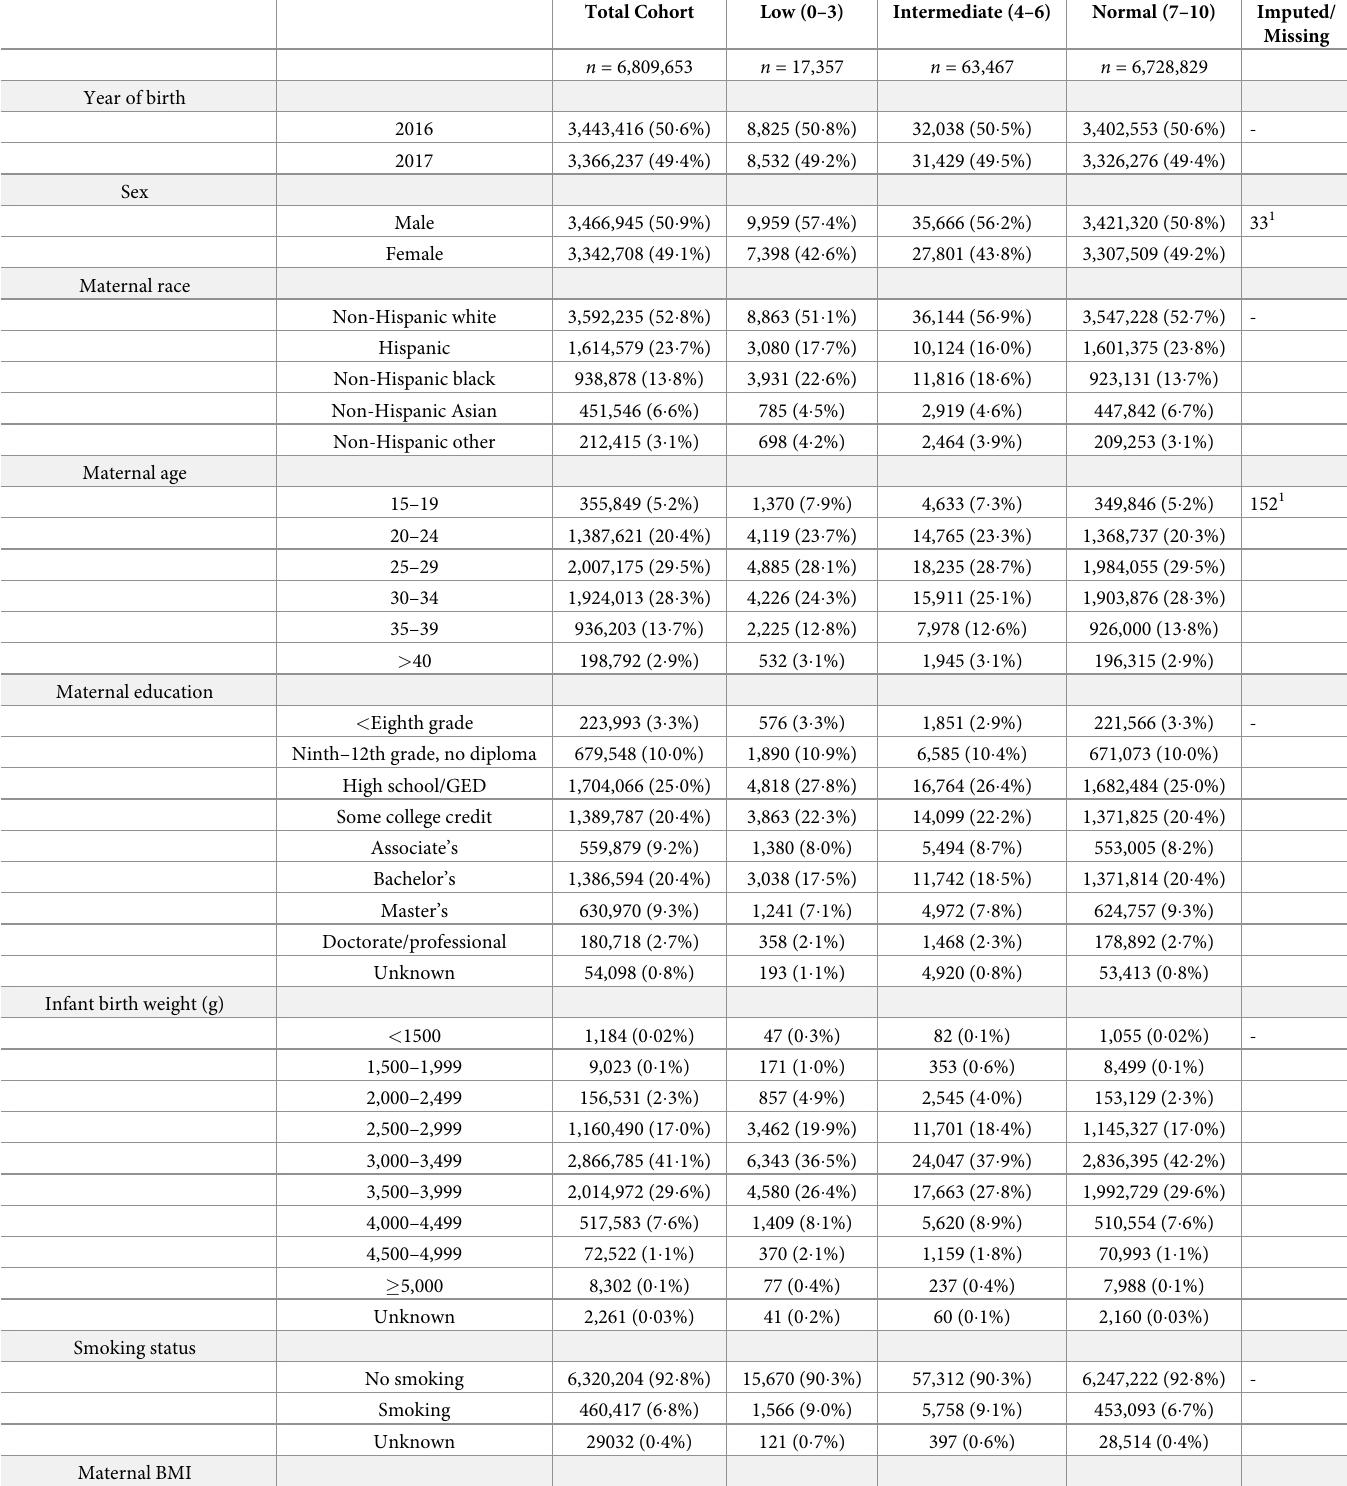
Table 1. Descriptive characteristics of study cohort, stratified by 5-minute Apgar